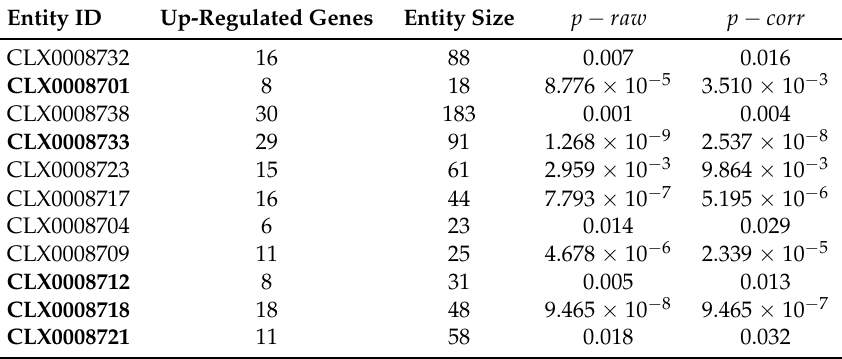
Table 1. Entities enriched for genes up-regulated at 4–8 h during appressorium development. Entities highlighted in bold are enriched for appressorium genes at both 4–8 h and 14–16 h